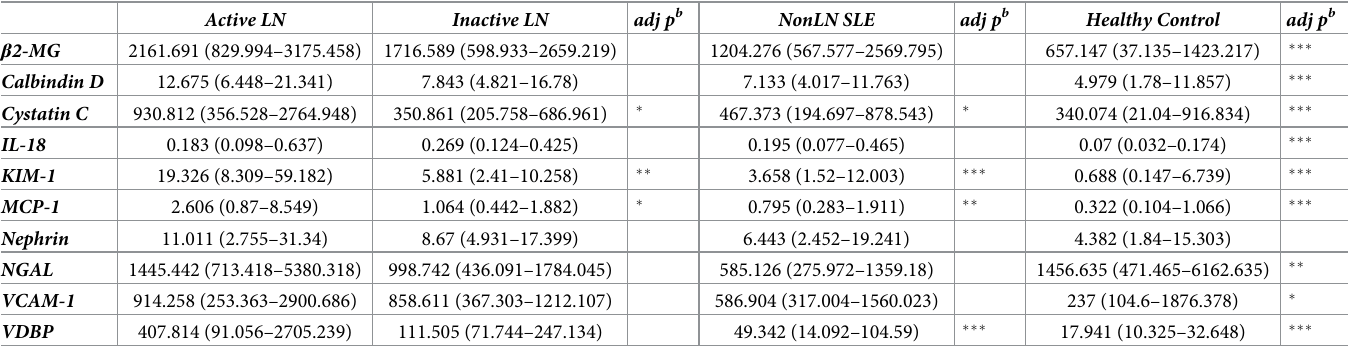
Table 2. UBMs levels in different groups of patients a . Active